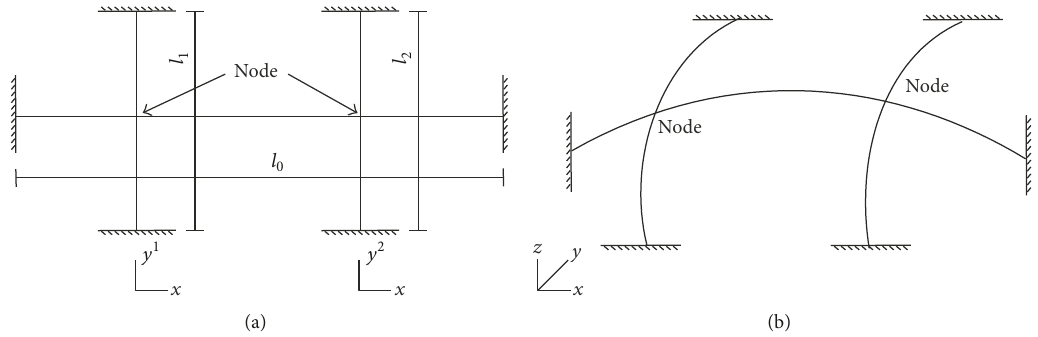
Figure 1: (a) The initial state of a tri-cross string. (b) The oscillating state of a tri-cross